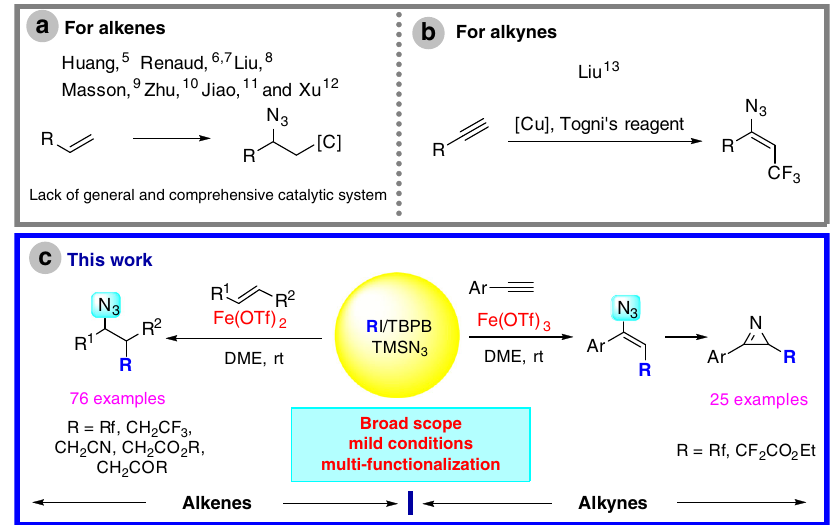
Fig. 1 Carboazidation of alkenes and alkynes. a Previous arts on carboazidation of alkenes. b Previous arts on carboazidation of alkynes. c This work: carboazidation of alkenes and alkynes